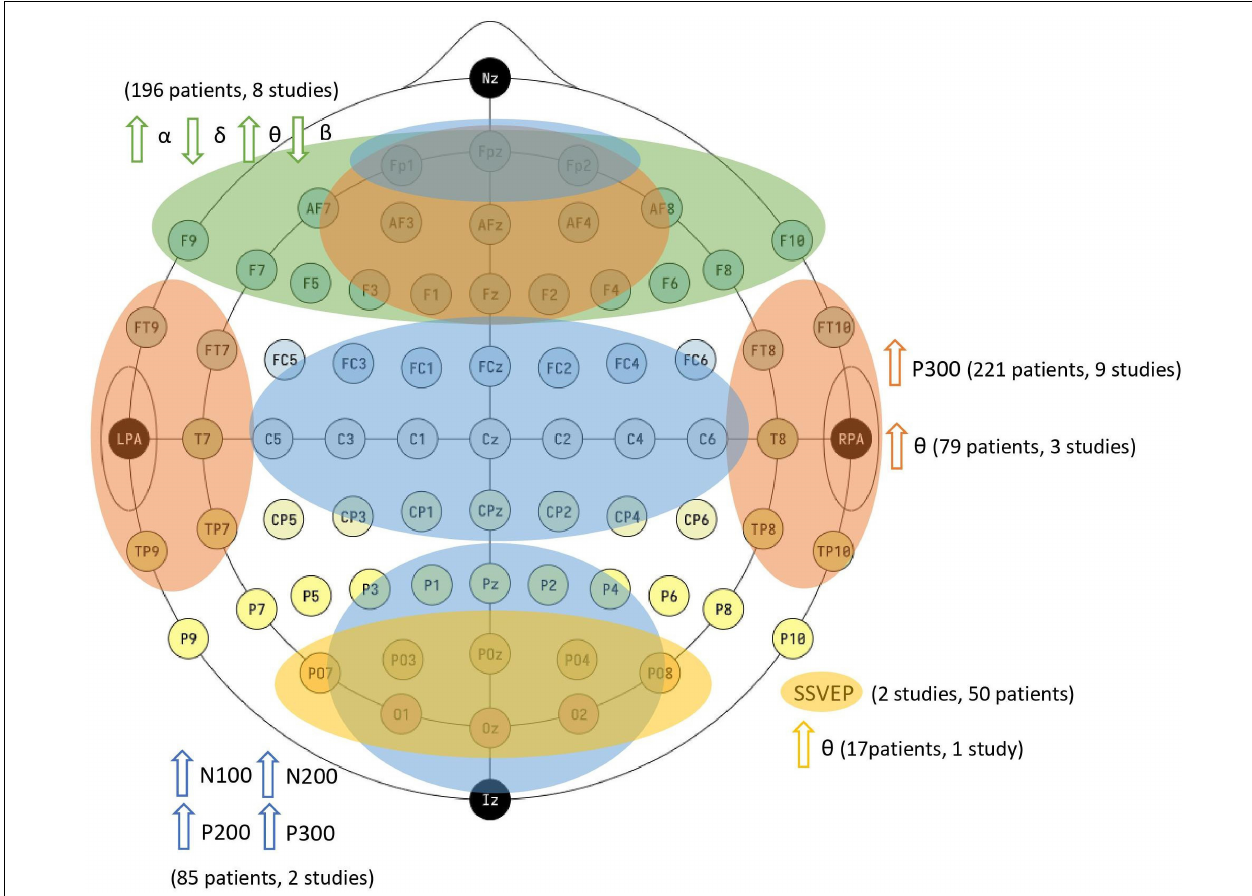
FIGURE 3 | Main predictors for identification of attention allocation, higher immersion states and higher cognitive load effects as found in the database. Image of public domain, by Laurens R. Krol. EEG electrode positions in the 10–10 system using modified combinatorial nomenclature. The electrode sites are color-coded according to the lobes of the brain which their labels (F, C, P, O, and T) represent. The head indicates the location of the fiducials: the nasion (Nz), the (left) pre-auricular point (LPA), the (right) pre-auricular point (RPA), and the inion (Iz). About the studies cited, up arrows are for increase of those features and down arrows for decrease. The studies and patients are detach from Supplementary Table 1 , here are grouped in methodologies and main predictors to indicated attention allocation and similar investigated states. The green color shades the frontal and pre-frontal areas (electrodes: Fp1, Fp2, Fpz, F1–F10, AF3, AF4, AF7, AF8, AFz, and Fz), in these areas the eight studies described in the ‘Main Findings’ section identify rising α and θ and declining δ and β in recognized attention allocation states; orange color shade is in fronto-parietal areas (Fp1, Fp2, Fpz, F1–F10, AF3, AF4, AF7, AF8, AFz, Fz, T7, T8, FT7–FT10, and TP7–TP10), in these areas eleven studies identify attention allocation by means of P300 presence or θ rising; blue color shade is in fronto-central-occipital (Fp1, Fp2, Fpz, FCz, C1–C6, FC1–FC6, CP1–CP6, Cz, CPz, O1, O2, PO3, PO4, PO7, and PO8), in these areas two studies identify from presence of event-related potentials N100, N200, P200, and P300 assigning attention allocation in the proposed methodologies; and yellow color shade comprises occipital area (O1, O2, PO3, PO4, PO7, and PO8), in three studies this area is related to the attention allocation investigation, by means of SSVEP technique or θ rising. The electrodes associated with those regions are processed by means of EEG signals, identifying to record changes in frequency bands and ERPs associated with changes in the attention